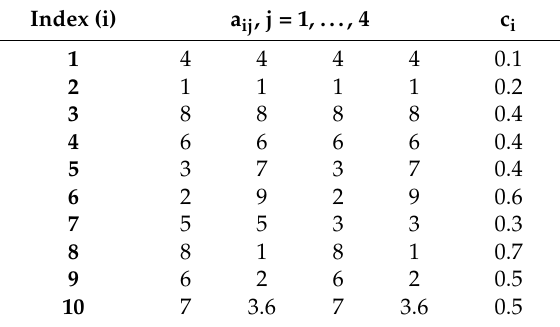
Table 8. Coefficients of Shekel’s Functions